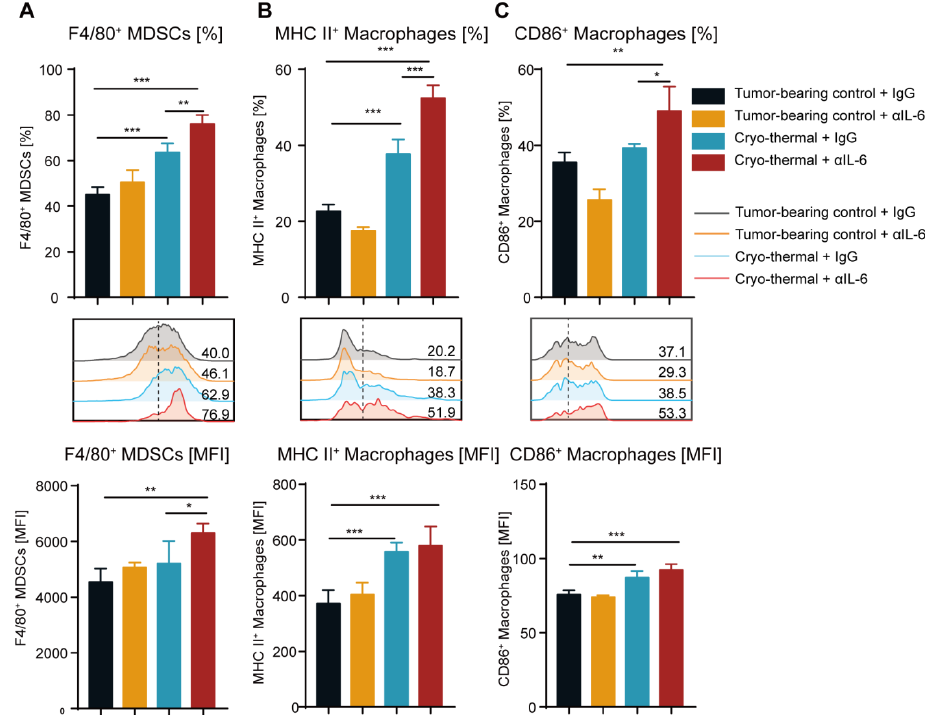
Figure 3. Combination therapy induced the differentiation of splenic MDSCs to macrophages and enhanced their maturation. ( A ) The frequency and MFI of F4/80 on splenic MDSCs. ( B , C ) The frequency and MFI of MHC II + ( B ) and CD86 + ( C ) macrophages in the spleen were detected by flow cytometry. n = 4 for each group. * p < 0.05, ** p < 0.01, *** p < 0.001. Data were analyzed using one-way ANOVA.